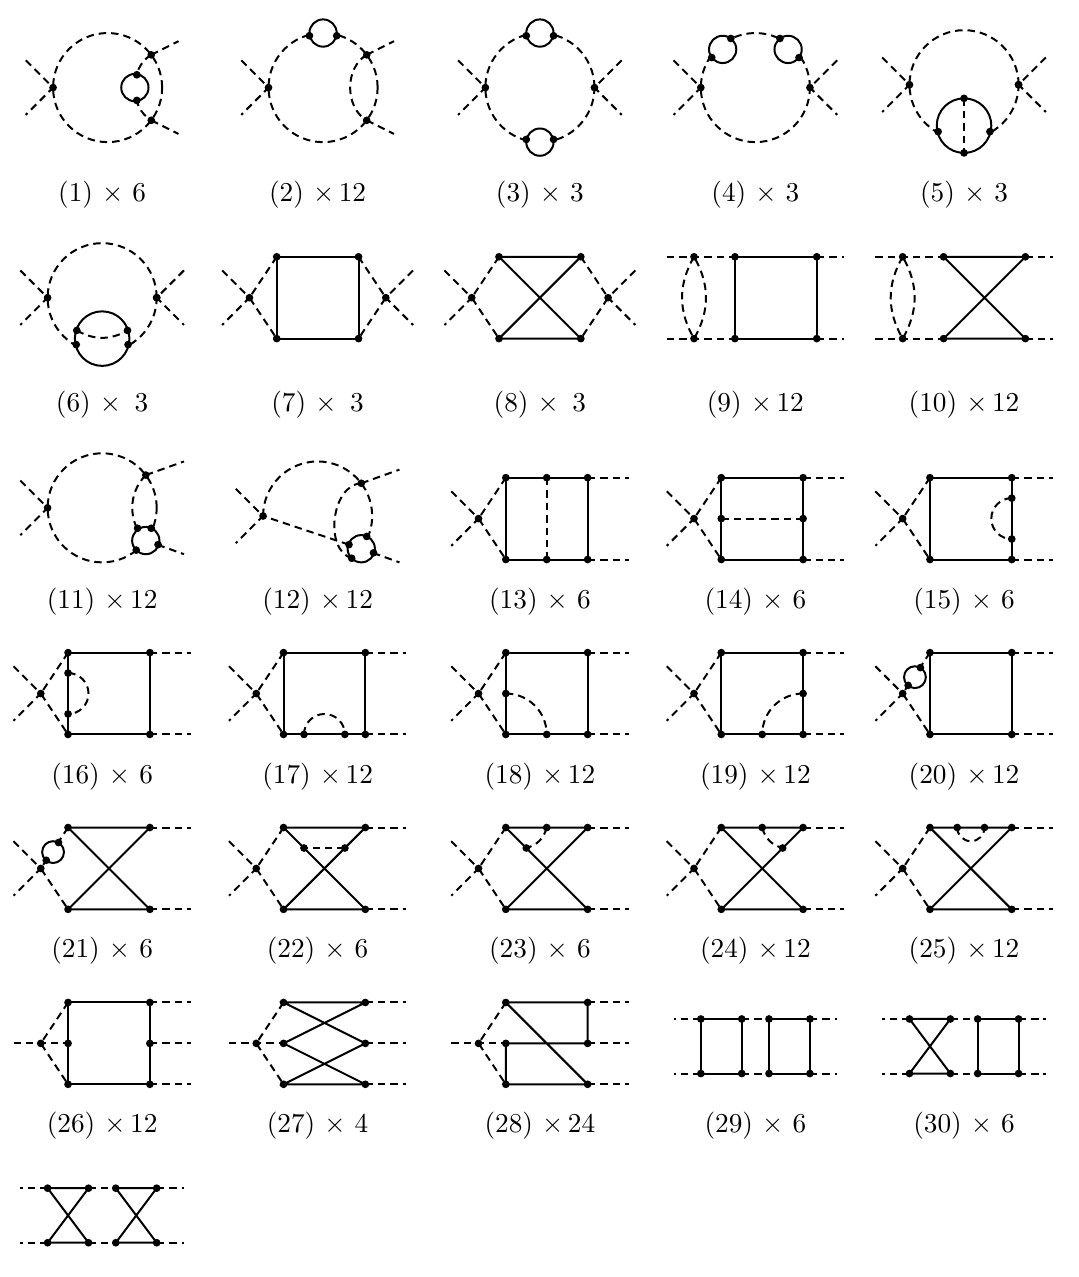
Figure 4 . Three-loop diagrams contributing to the scalar quartic vertex renormalisation, contain- ing both quartic and Yukawa vertices. Solid [dashed] lines correspond to fermionic [scalar] propaga- tors. The number of inequivalent permutations of the external legs for each diagram is also